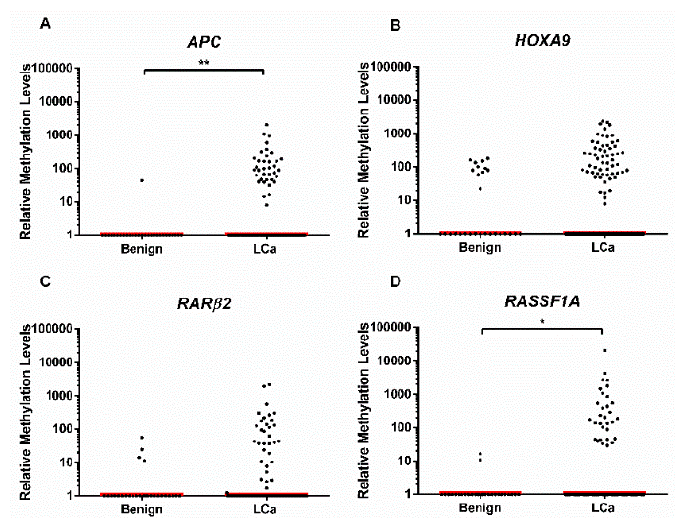
Figure 1. Scatter plot of ( A ) APC (number of values that fall in the x axis: benign = 27, LCa = 93), ( B ) HOXA9 (number of values that fall in the x axis: benign = 17, LCa = 71), ( C ) RAR β 2 (number of values that fall in the x axis benign = 24, LCa = 92), and ( D ) RASSF1A (number of values that fall in the x axis: benign = 26, LCa = 98); methylation level distribution among lung cancer (LCa) patients from study group #2 (plasma samples) and benign lung diseases patients from study group #3 (plasma samples). Mann–Whitney U test. * p < 0.05, ** p < 0.01. Red horizontal line represents the median methylation level.